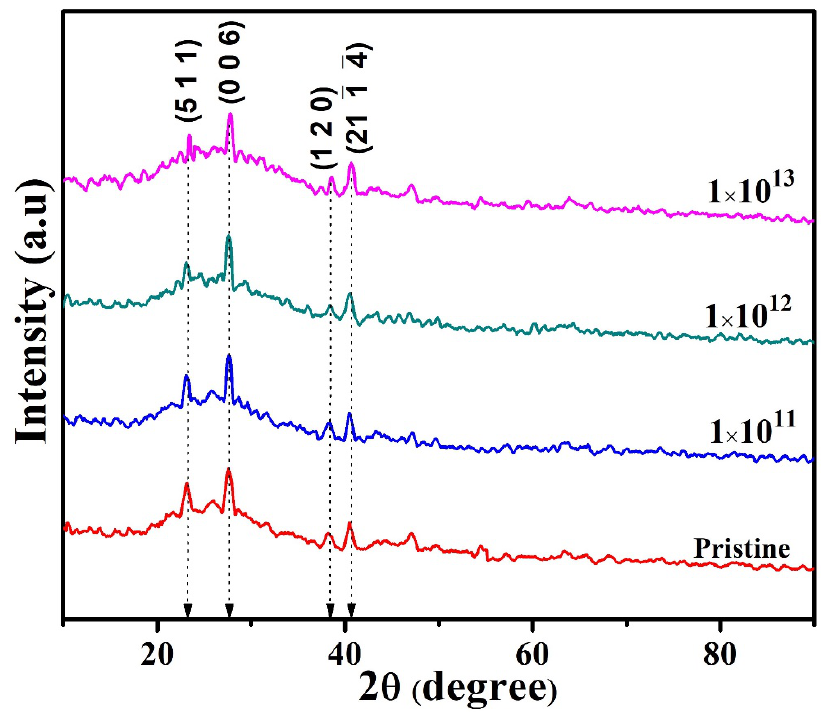
Figure 2. XRD patterns of pristine and irradiated In 2 (Te 0.98 Se 0.02 ) 3 films.